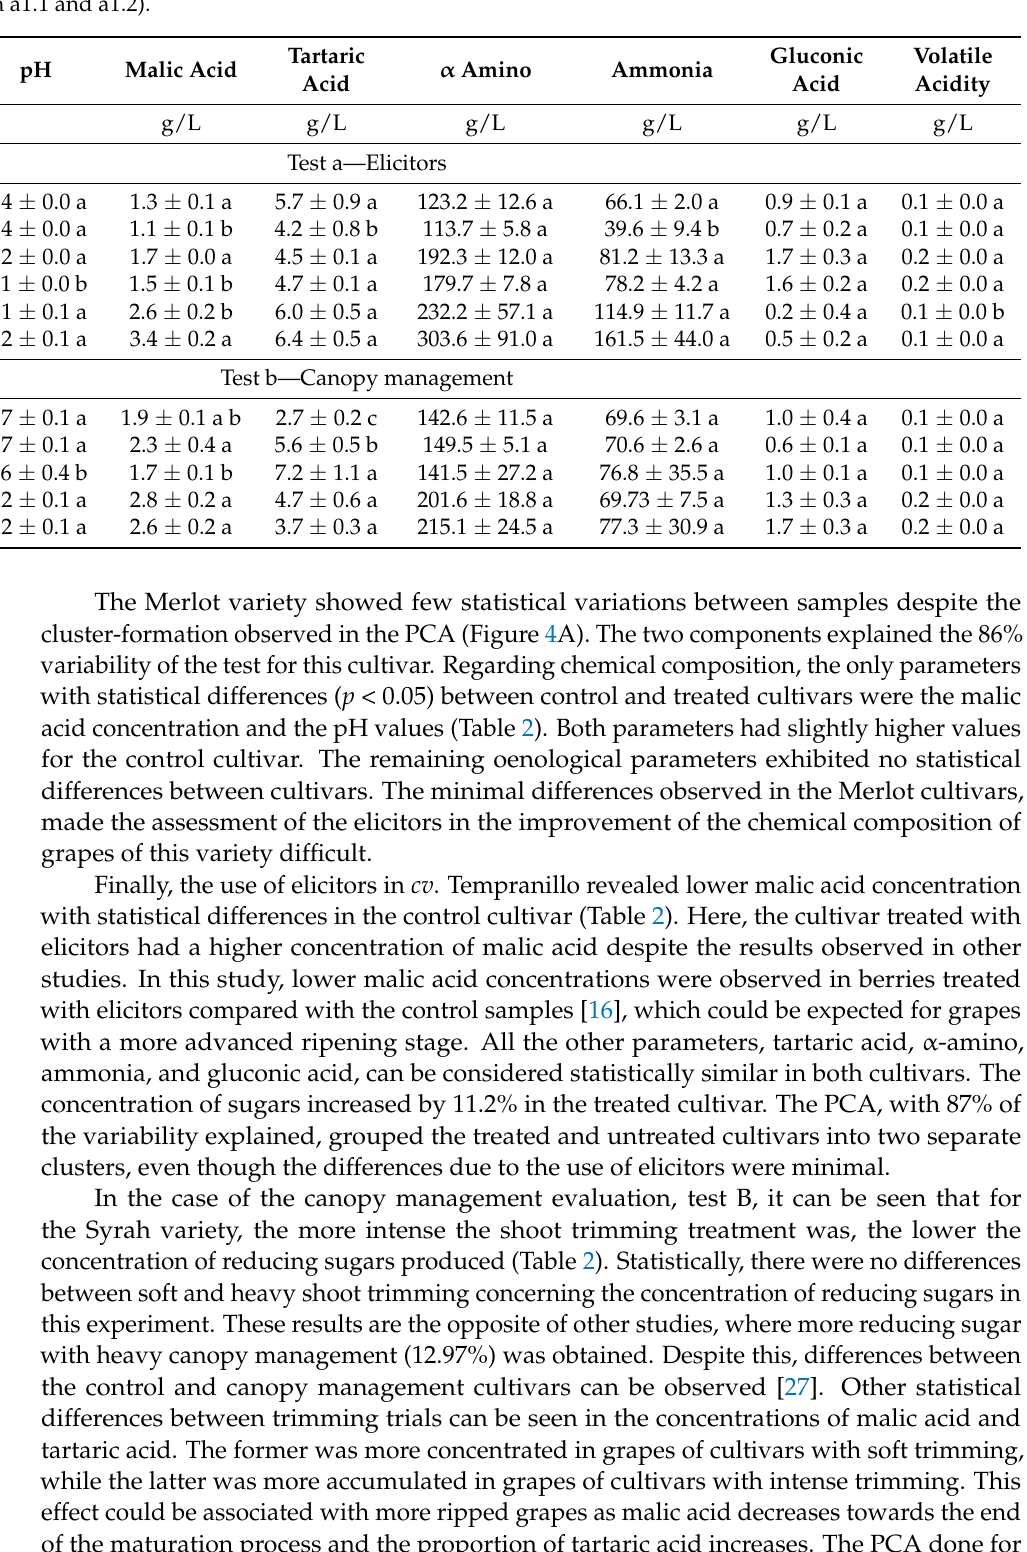
Table 2. Oenological parameters determined with FTIR. Comparison of blocks with elicitors and canopy management systems against controls. Average and standard deviation. Different letters indicate statistical differences ( p < 0.05) for each treatment (e.g., between a1.1 and